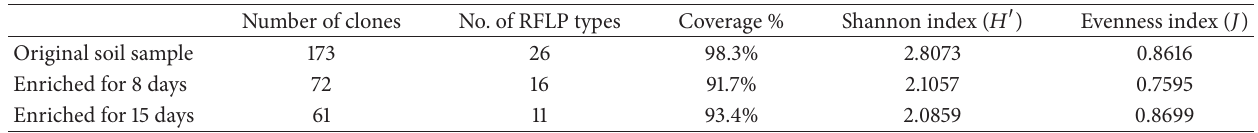
Table 2: Estimates of coverage percent, Shannon diversity, and evenness index for BN-15 original and enriched soil samples.